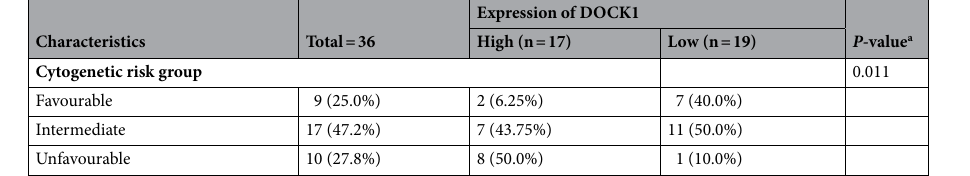
Table 4. Correlation between DOCK1 expression and cytogenetic risk of 36 cases with acute myeloid leukemia patients. a P -value indicates the significance for the comparison between higher and lower DOCK1 expression (cut by the mean expression level of DOCK1) in 36 cases with acute myeloid leukemia